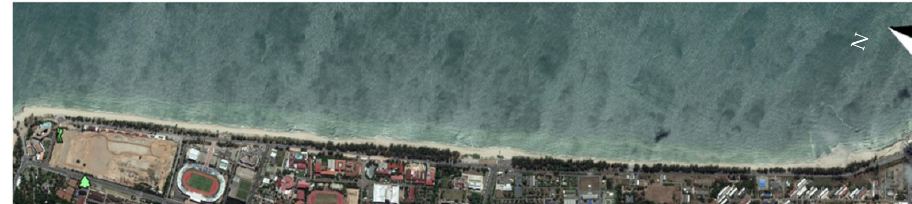
Figure 4. Chalatat beach.